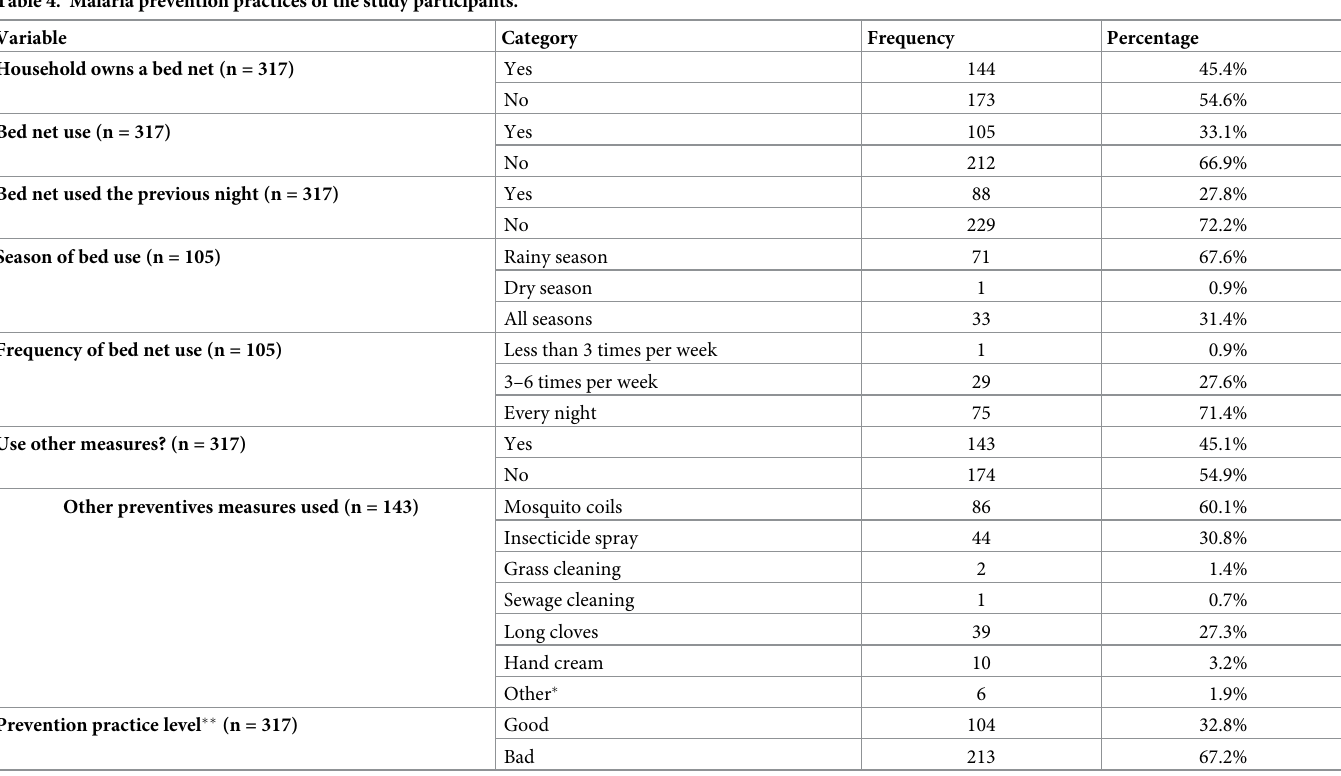
Table 4. Malaria prevention practices of the study